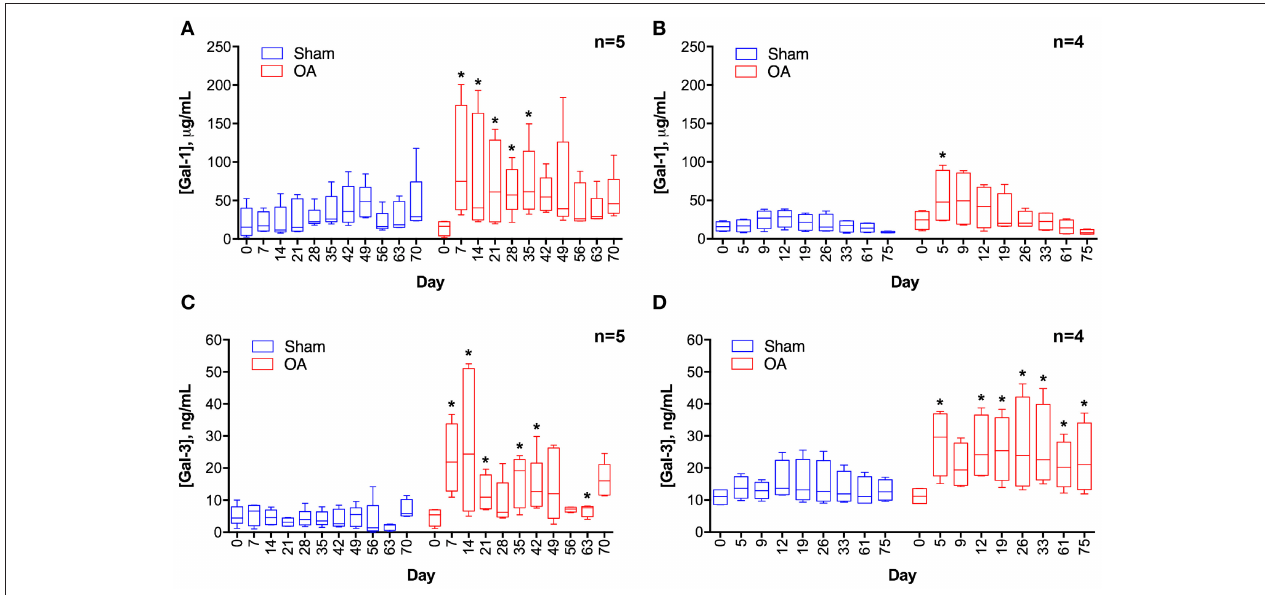
FIGURE 1 | Galectin-1 (A,B) and galectin-3 (C,D) concentrations in equine synovial fluid prior to (day 0) and after arthroscopically-induced osteochondral fragmentation (OA) or sham operation (Sham). Data are displayed as box-and-whisker plots representing the first and third quartiles, median, and spread of concentrations for each serial sampling time point. ELISA data in (A,C) were obtained from the same cohort of horses ( n = 5), and ELISA data in (B,D) were obtained from a second cohort of horses ( n = 4). Mixed linear model derived P -values for the fixed effect of treatment and day were < 0.001 for models A-D, except for D where day P = 0.32. An interaction between treatment and day was identified for model A (treatment * day P = 0.0007) and C (treatment * day P = 0.03). Note that there is variation in the date of synovial fluid sampling between the two cohorts. Asterisks denote days where OA galectin concentrations were significantly increased as compared to Sham, * = P < 0.05 after Bonferroni correction.